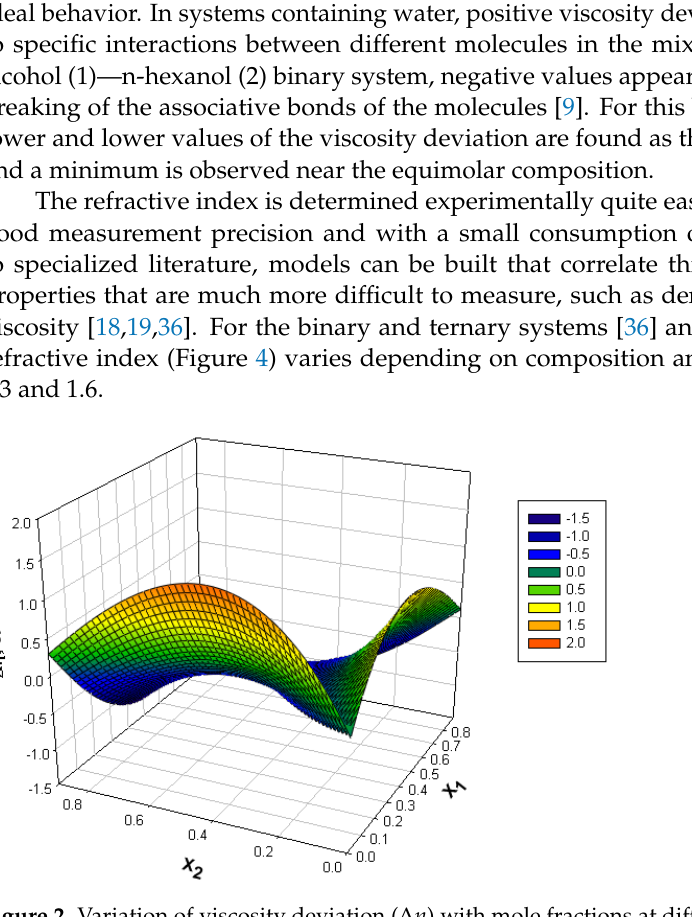
Figure 3. Viscosity deviation values for the benzyl alcohol (1) — n-hexanol (2) binary system. Figure 4. Variation of refractive index with mole fractions at different temperatures.